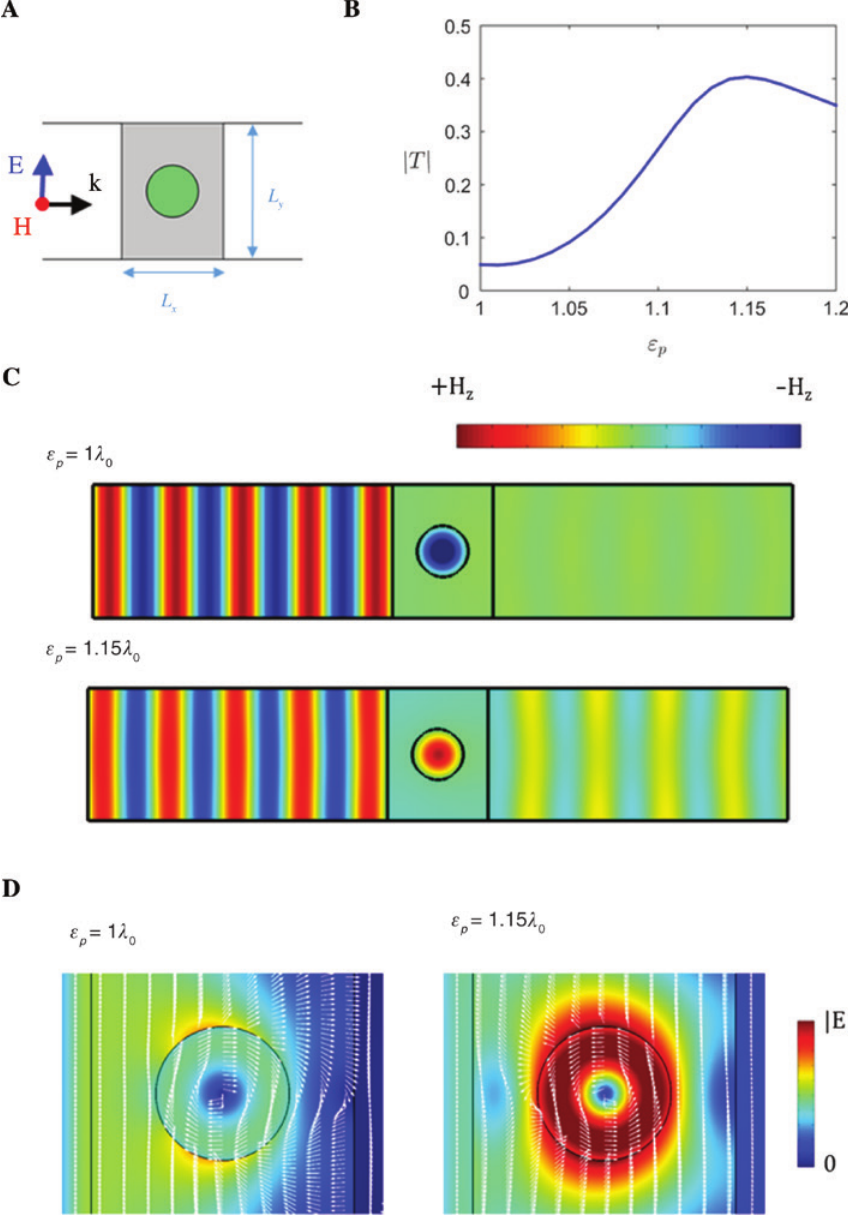
Figure 5: ENZ metasurfaces for microfluidics. (A) Sketch of the geometry: ENZ metasurface composed of rectangular unit cells of size L = 0.381 λ radius r . We assume that a fluid with low-permittivity ε p p (B) Transmission coefficient as a function of the relative permittivity of the fluid. (C) Snapshot of the magnetic field distribution for ε = 1.15 corresponding to the minimum and maximum of transmission, respectively. (D) Electric field distribution (color map of the field and ε p magnitude and normalized vectorial plot) characterized by resonantly enhanced circulating fields within the microfluidic